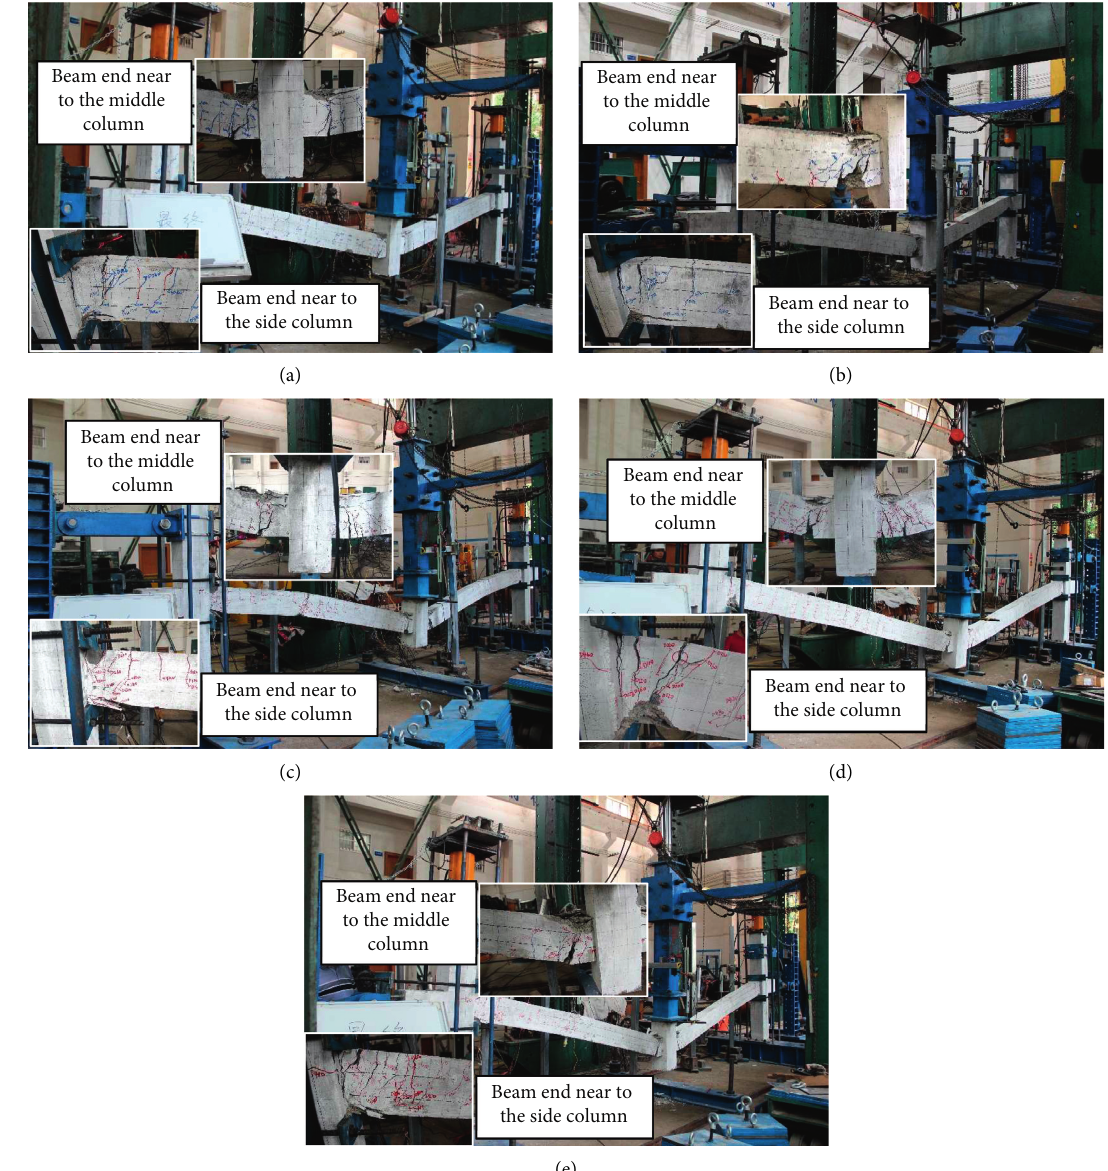
Figure 5: Failure patterns of the specimens. (a) S1. (b) S2. (c) S3. (d) S4. (e)